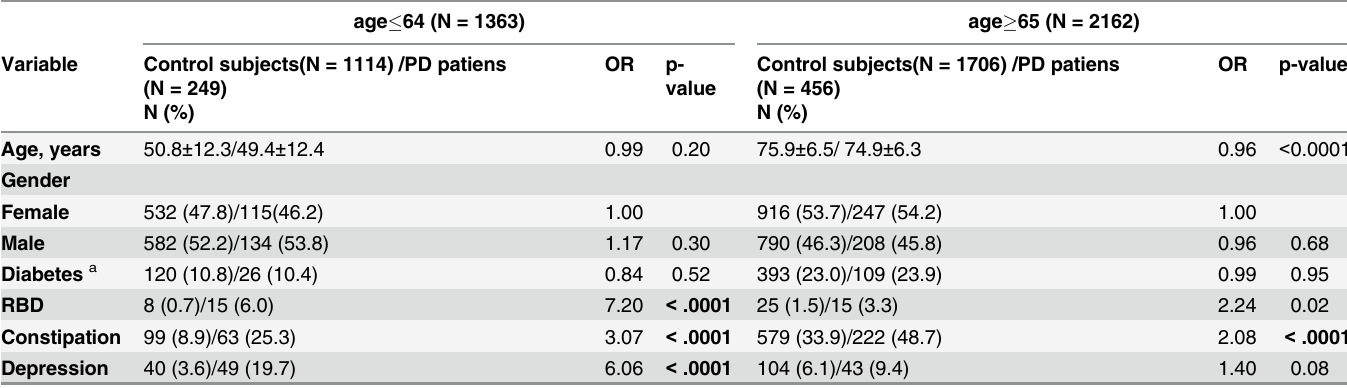
Table 5. Comparisons and odds ratio of the depression/constipation/RBD distribution between study subjects with and without PD, category by age